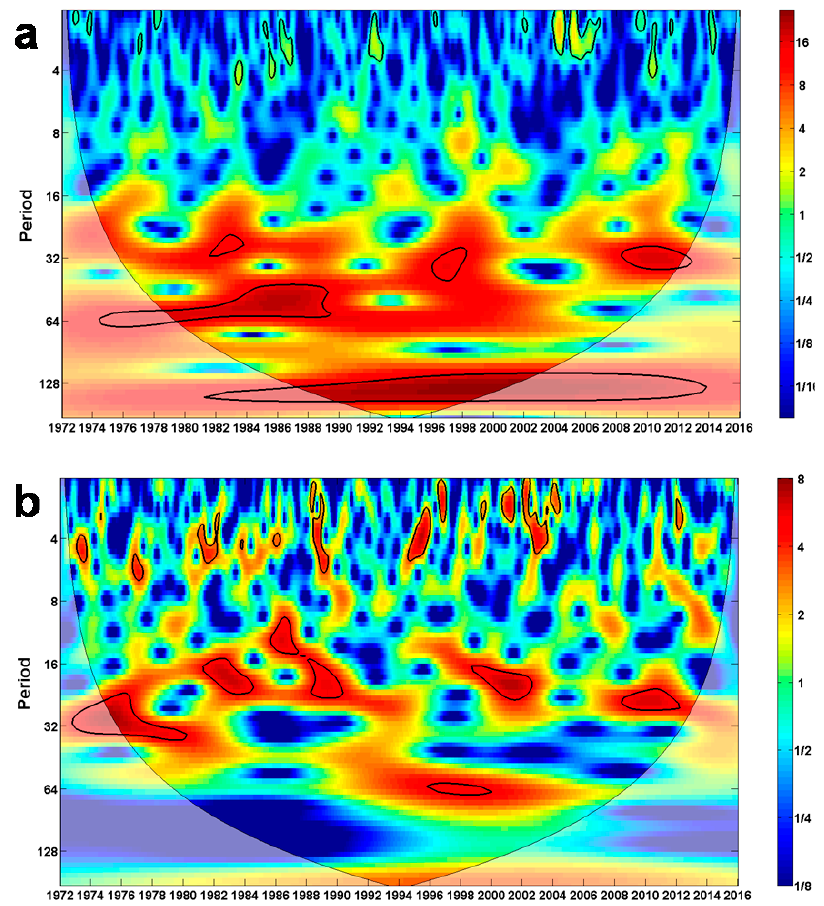
Figure 4. Continuous Wavelet Transform of SOI ( a ) and SAMi ( b ). The thick black contour encloses regions of confidence for a red-noise process greater than 95%. Thin black lines designate the COI in which the edge effects might affect the results. In these spectra, low values of the scale match the high frequencies.